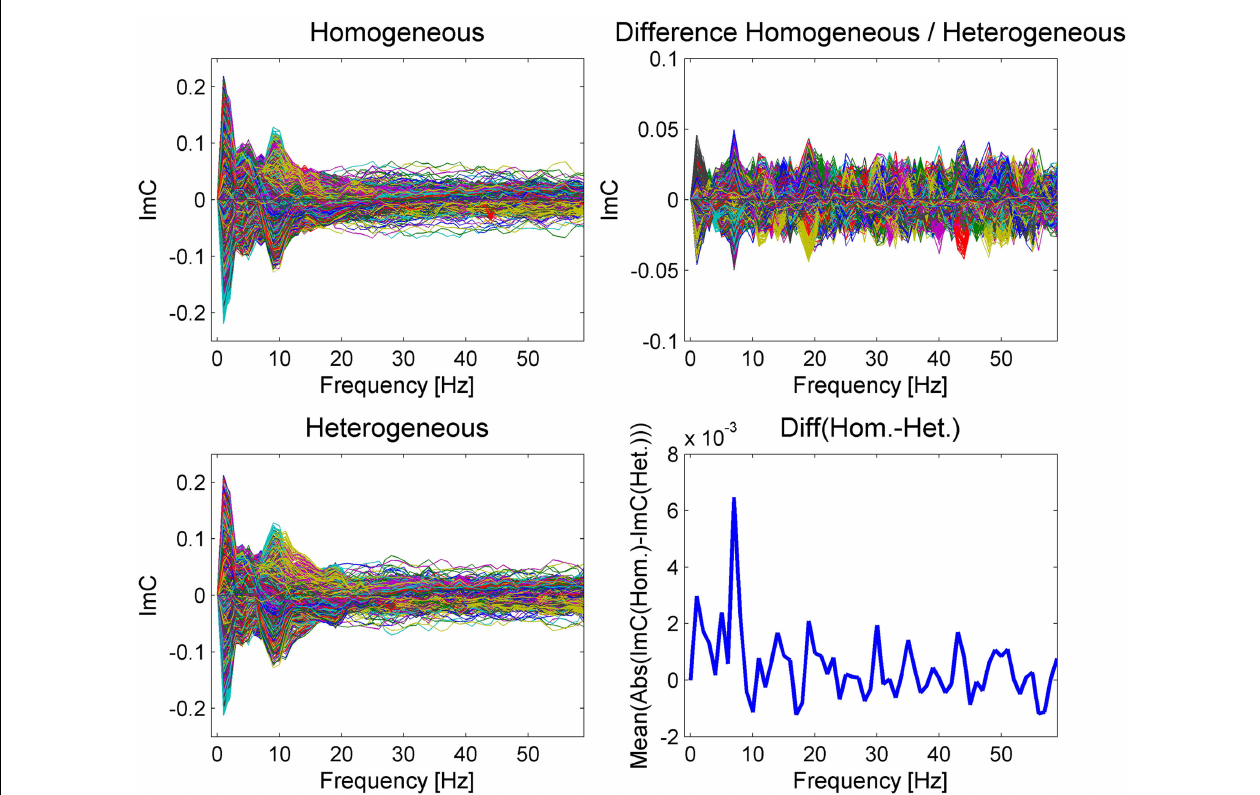
at 7Hz, which is less visible in the individual condition plots due to overlapping modulations common to both conditions. Please note that the ImC is an antisymmetric measure meaning that the ImC of channel A to channel B equals minus the ImC of channel B to channel